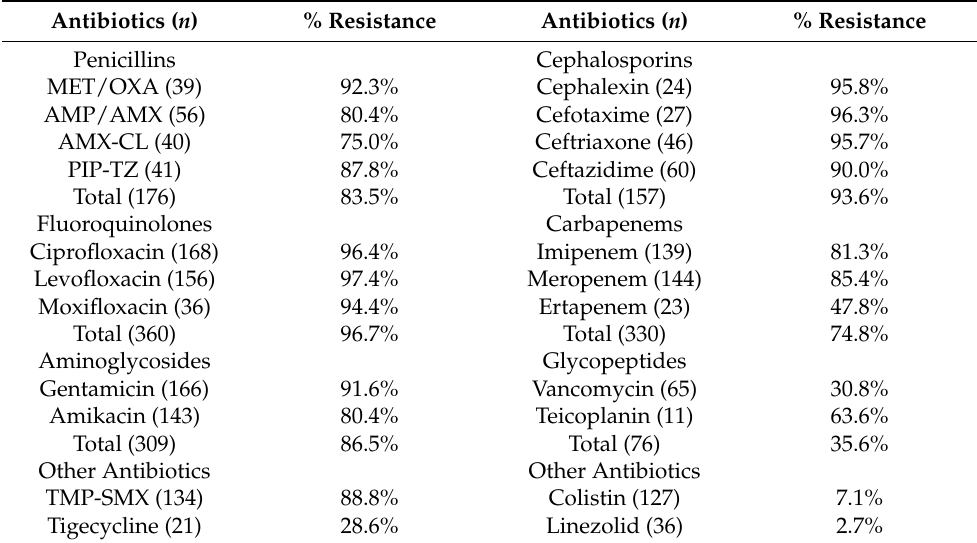
Table 3. Antimicrobial susceptibility testing results from April 2019–April